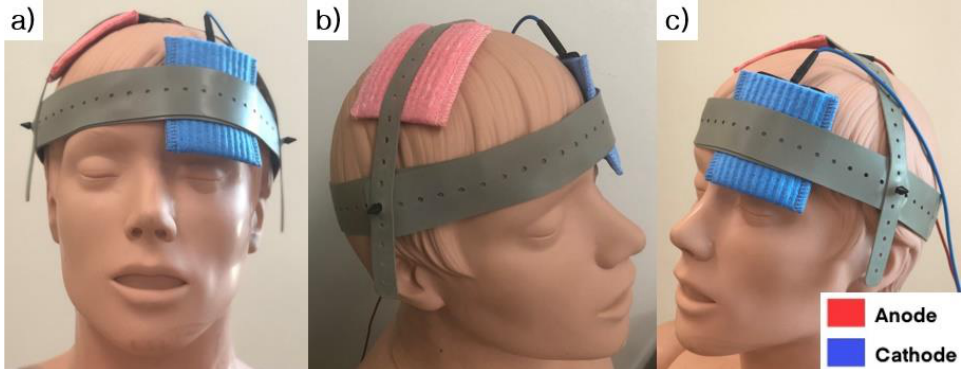
Figure 2. The location of the stimulating electrodes used for transcranial direct current stimulation. ( a ) right oblique view, ( b ) front view and ( c ) left oblique view are presented. The anode electrode (Red) was placed over the motor hotspot of the first dorsal interosseous (FDI) on the non-dominant hemisphere; the cathode electrode (Blue) was placed on the contralateral supraorbital area.